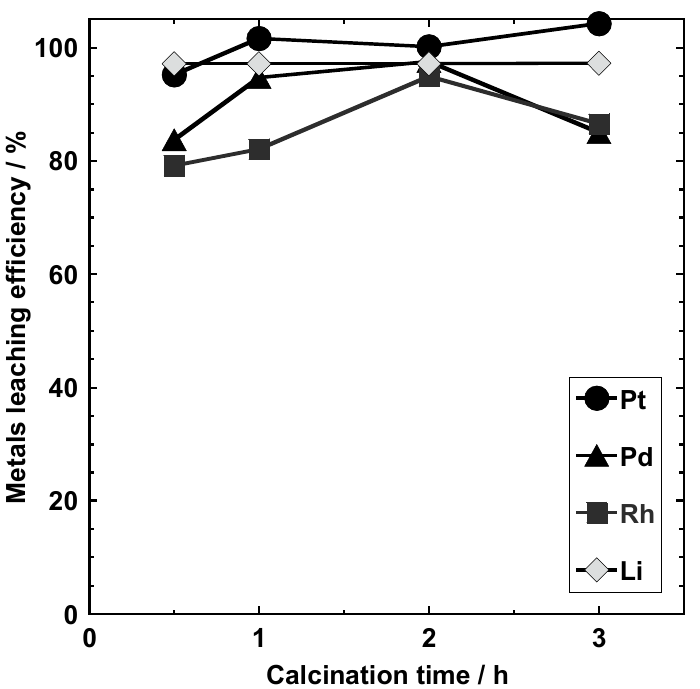
Figure 11. Pt, Pd, Rh, and Li leaching efficiencies of the samples obtained under conditions I-E-1, I-E-2, I-E-3, and I-E-4.